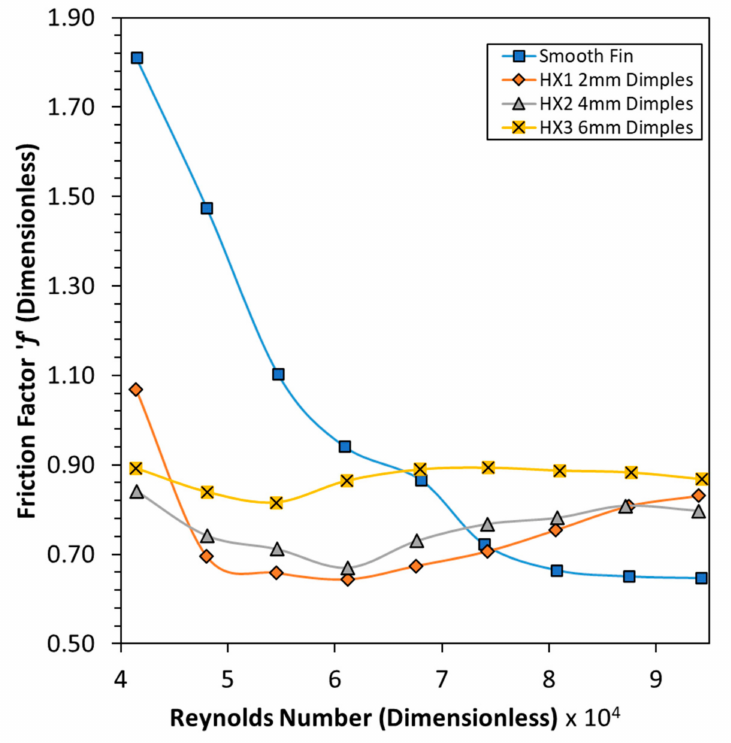
Figure 12. Comparison of friction factor value between smooth, 2 mm, 4 mm and 6 mm dimples engraved on NACA/elliptical